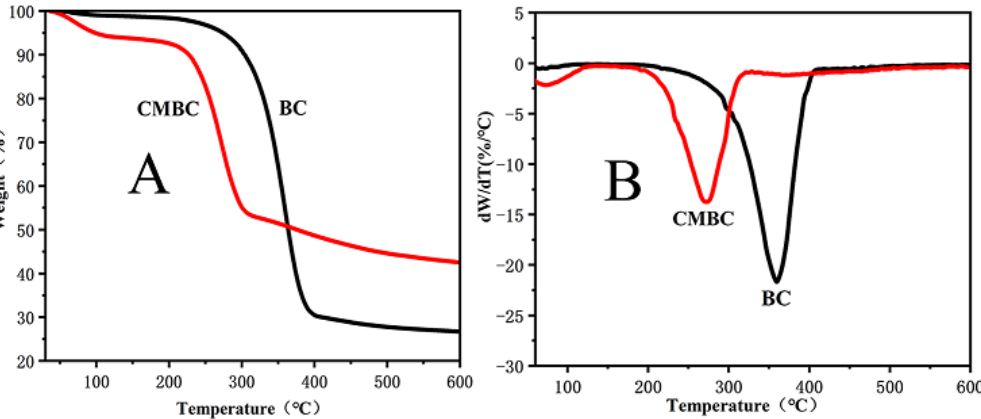
Figure 5. Thermogravimetric analysis ( A ) and differential thermogravimetric analysis ( B ).